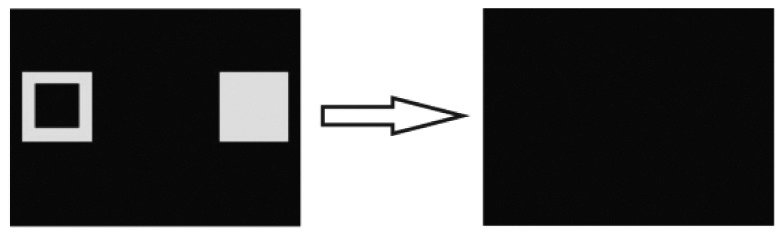
Succession of the sequence of PowerPoint slides used in experiment 3.The positive stimulus is shown on the left. The last slide denotes the ITI.